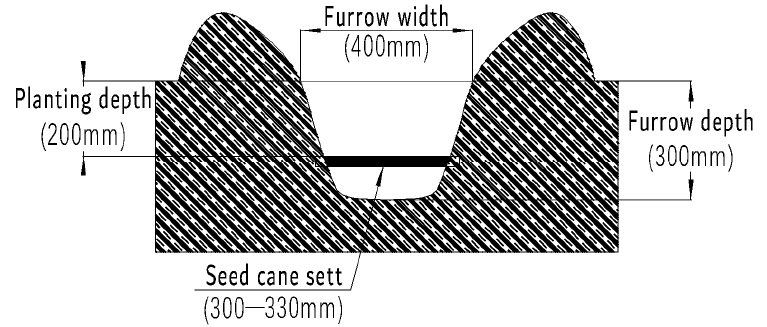
Figure 1. Transverse planting of a seed cane sett.